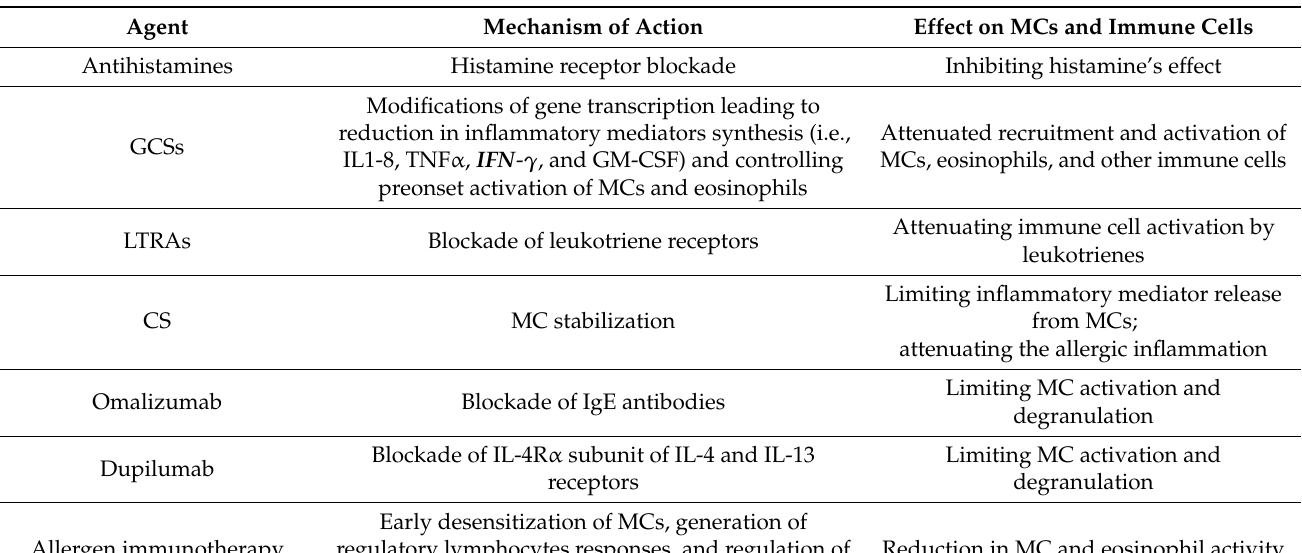
Table 1. Summary of pharmacotherapy in AR. Summary of the discussed therapeutic agents, their main mechanism of action, and their main effects exerted on MCs and immune